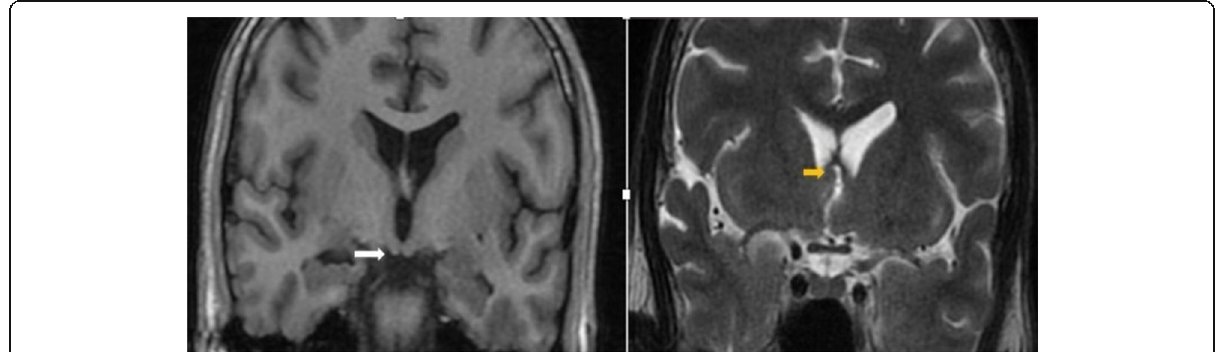
Fig. 3 Coronal MRI of brain showing mammillary body atrophy on the right side (white arrow) and right fornix atrophy (yellow arrow) in the patient with focal onset seizure with impaired awareness